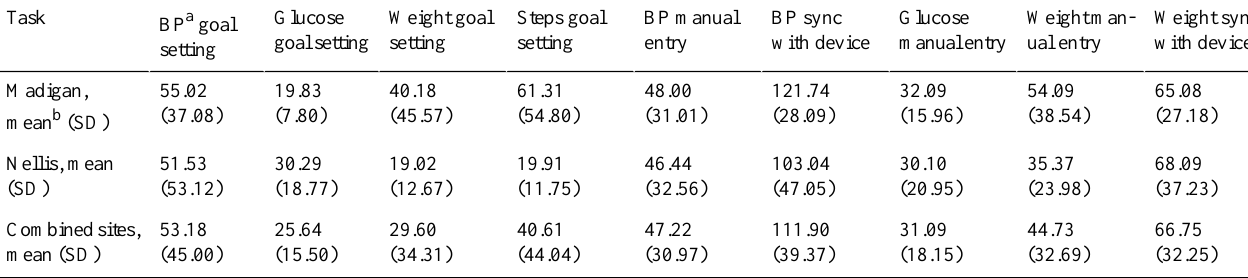
Table 2. Participant efficiency with